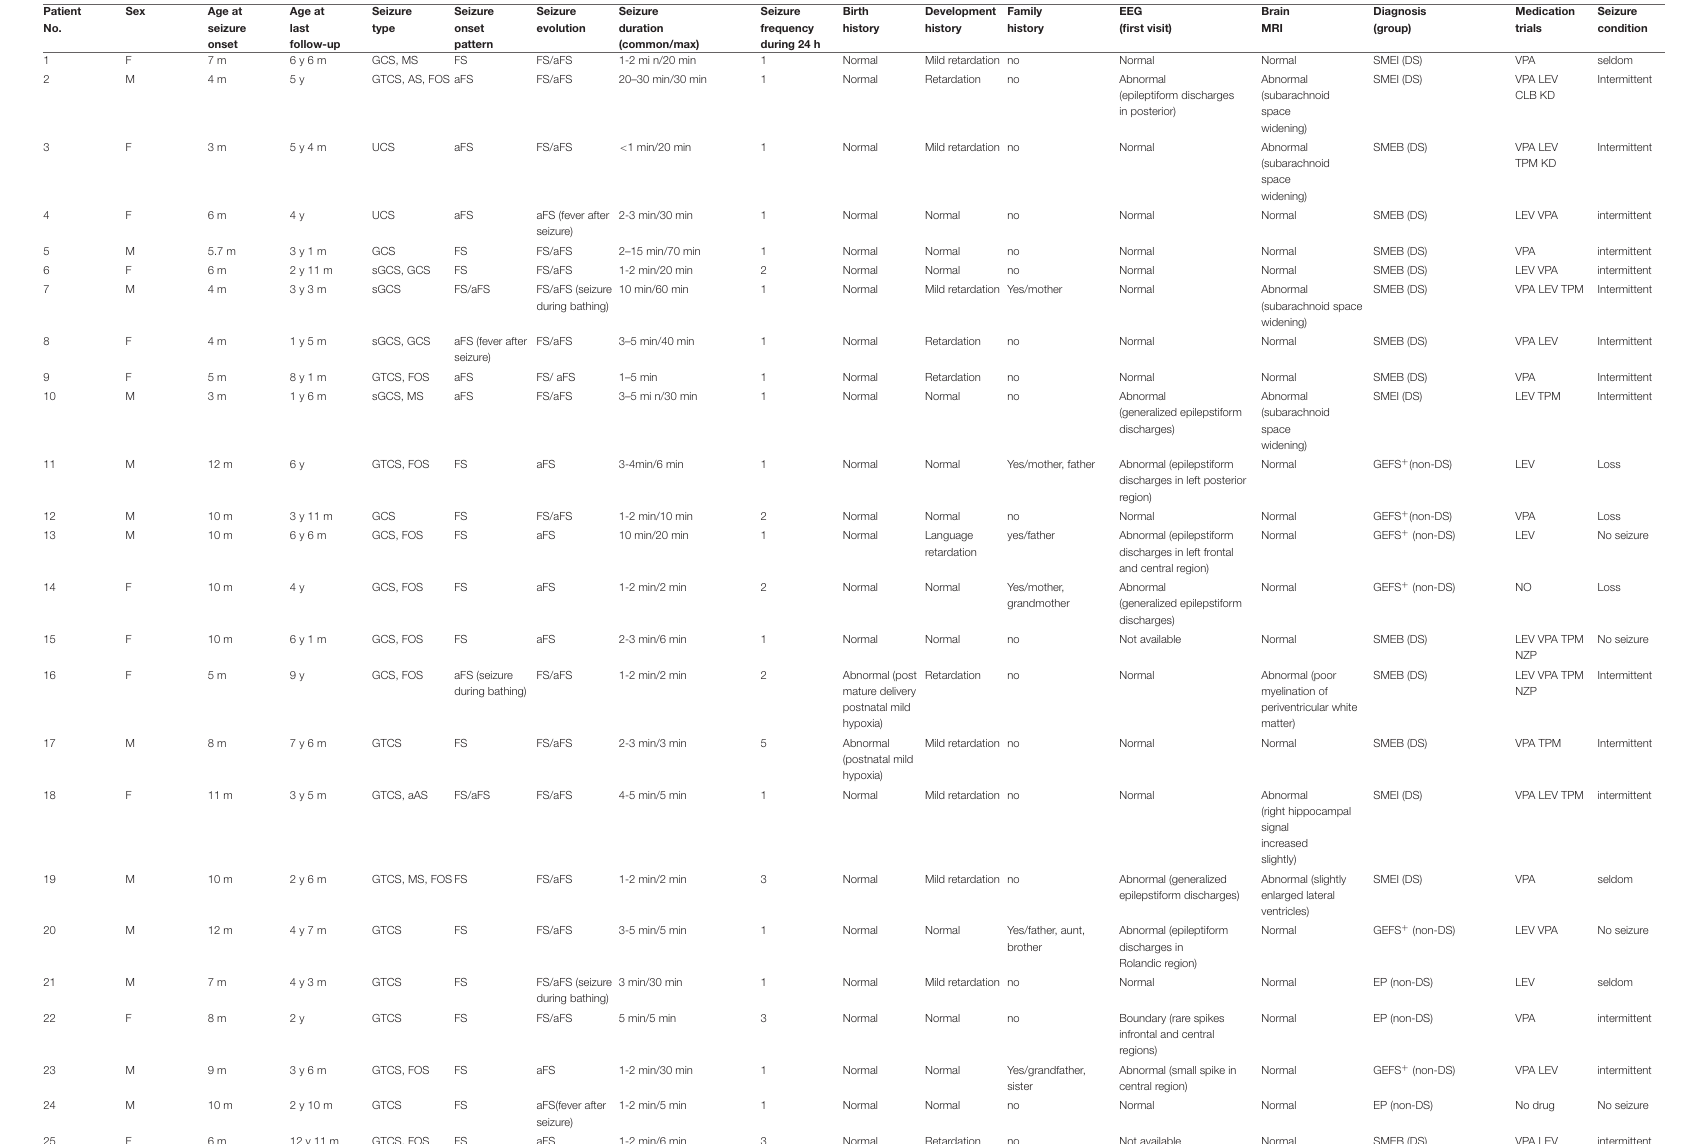
TABLE 1 | Clinical features of patients with SCN1A variant. Patient No.